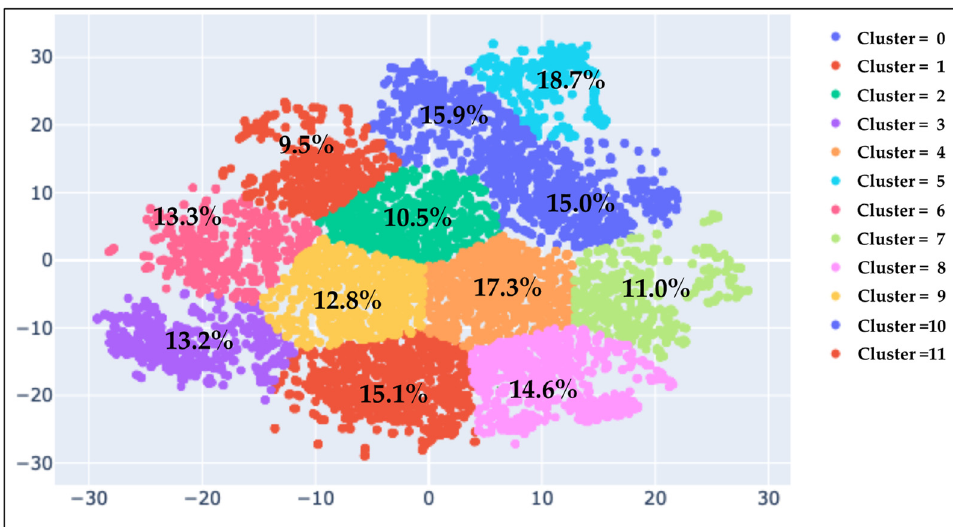
Figure 2. Comparison of the selection frequencies of users with type 2 diabetes mellitus for each nutritional cluster.